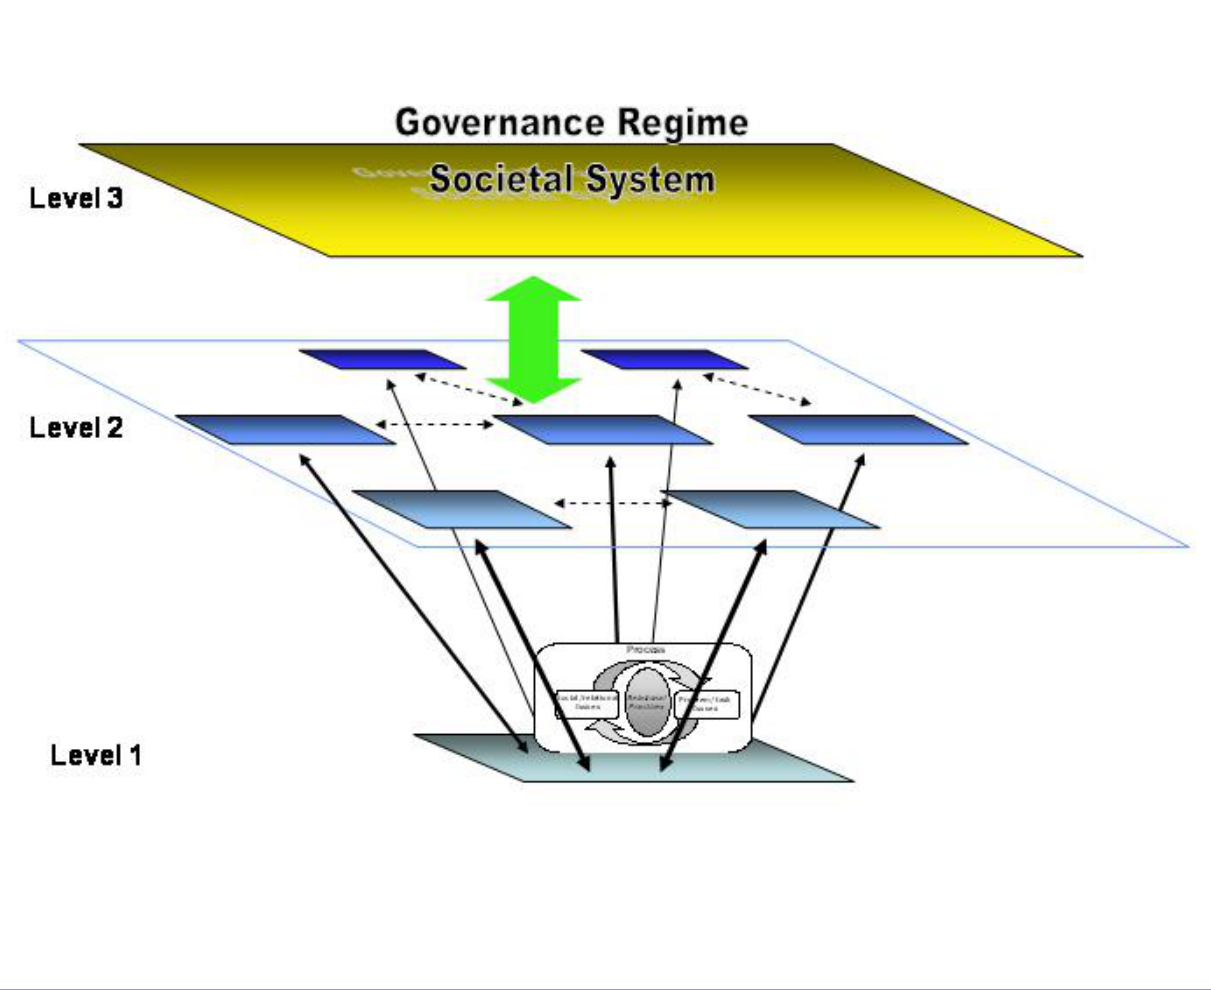
Fig. 2 . Three-level representation of multiscale social learning processes: (1) Level 1 (micro): the multiparty collaboration process in which representatives from different stakeholder groups interact. As indicated, this level refers to the process level in the center of Fig. 1; (2) Level 2 (meso): the actors in the water management regime consisting of more or less organized stakeholder groups, e.g., authorities, associations, who may partly engage in bilateral interactions; and (3) Level 3 (macro): the governance and societal structural conditions that are characterized by cultural values, governance regime, or power structures. This level is identical to the conceptual framework illustrated in Fig.